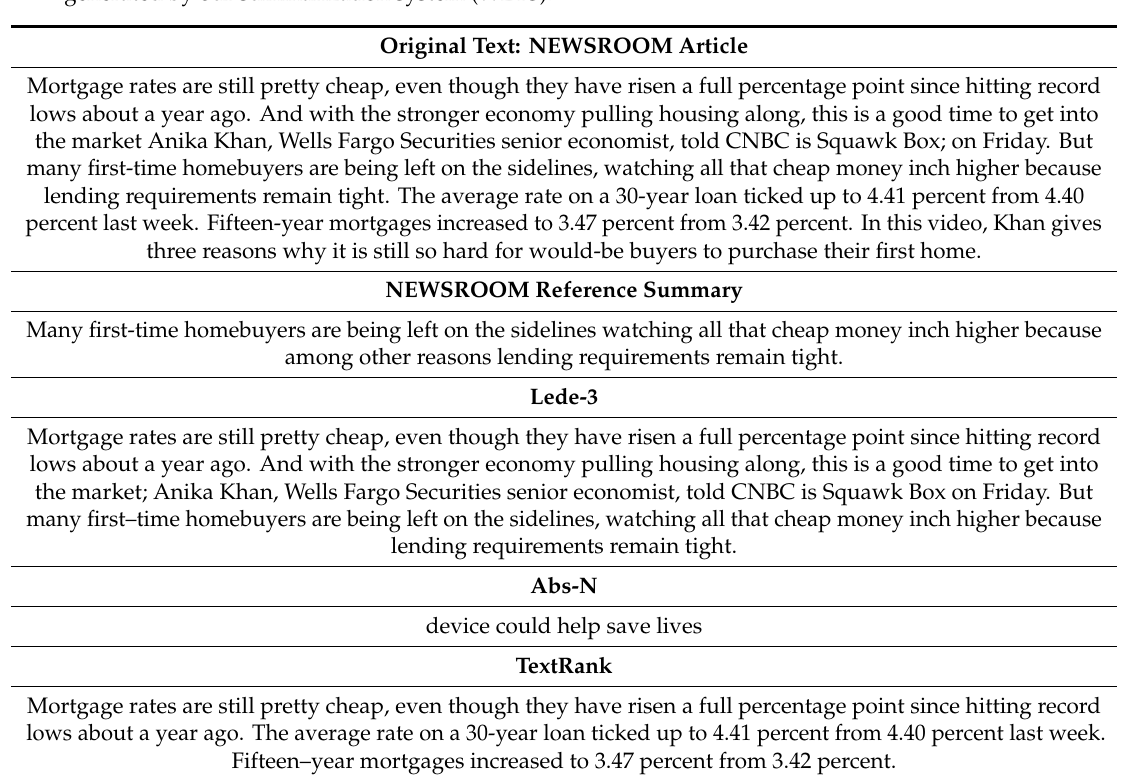
Table 3. Sample dataset: original text, reference summary, baseline systems summaries and summary generated by our summarization system